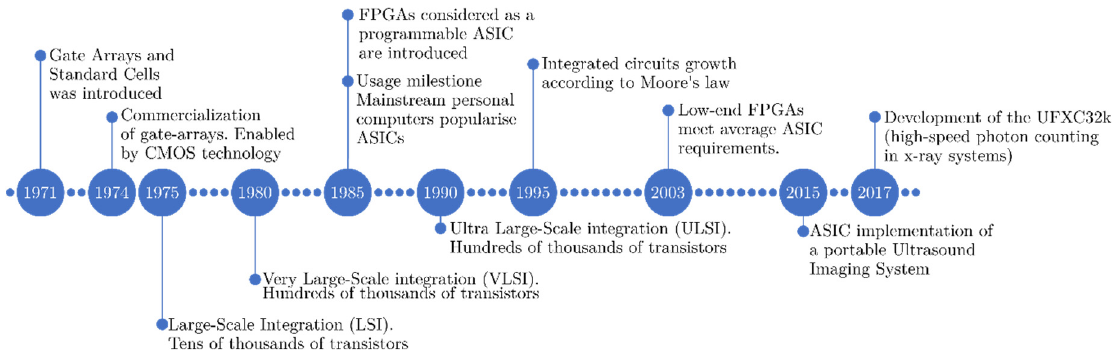
Figure 5. Most significant milestones over time on ASIC-based hardware acceleration for image processing.